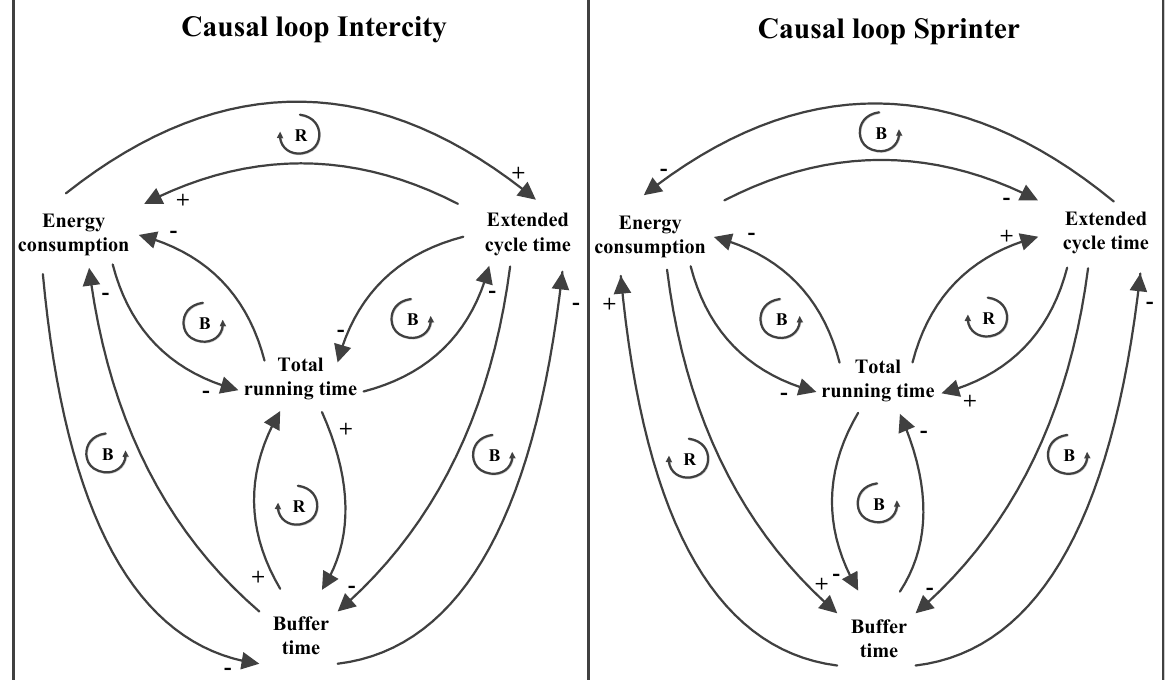
Figure 11: The left plot shows for the case Ah-Nm the causal loop diagram between the objec- tives for the IC. The right plot indicates for the case Ah-Nm the causal loop diagram between the objectives for the SPR (legend: 𝑅 = Reinforcing, 𝐵 = Balancing, + = objective at the end of the ar- row is moving in the same direction as the objective at the beginning of the arrow, and − = objec- tive at the end of the arrow is moving in the opposite direction as the objective at the beginning of the